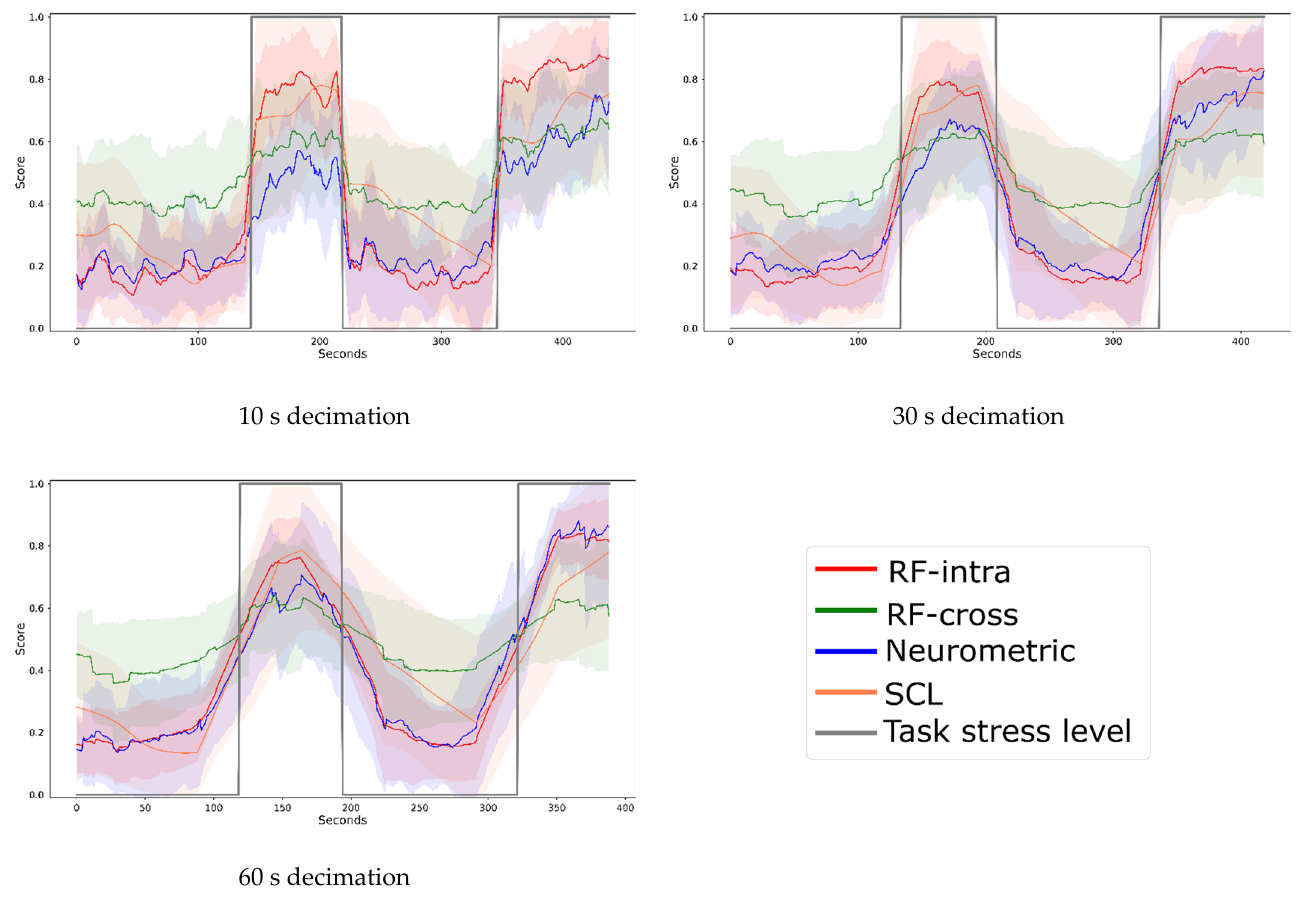
Figure 8. Stress during the driving experiment. The time series were obtained from the four different models at three different decimations (10, 30 and 60 s). The line represents the average over the population of recorded stress value, and the shadow represents the standard deviation. The expected value of stress level (low and high-stress condition) is represented in grey, the Random Forest calibrated cross-task (RF-cross) is represented in green, the Random Forest calibrated intra-subject (RF-intra) in red, the Neurometric in blue, and the Skin Conductance Level (SCL) in